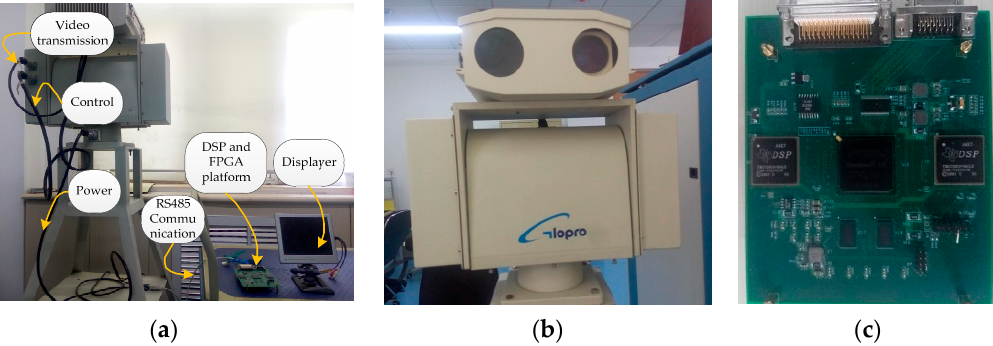
Figure 4. ( a ) Our moving object detecting system and the description of each component; ( b ) the high-precision intelligent holder; and ( c ) the platform of FPGA (Field Programmable Gate Array) and DSP (Digital Signal Processor). DSP (Digital Signal